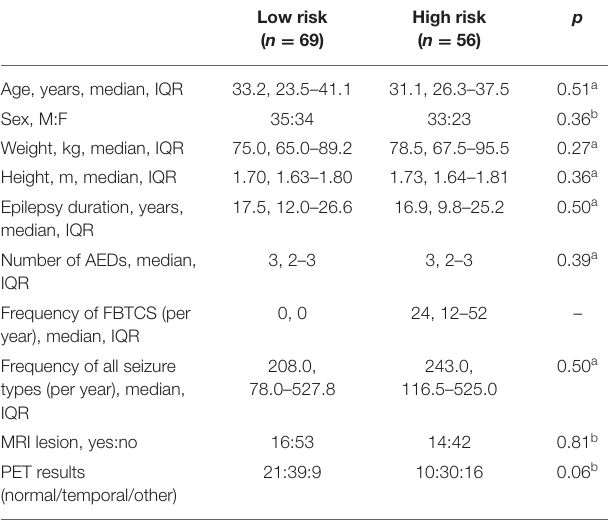
TABLE 1 | Group characteristics of patients with high and low SUDEP